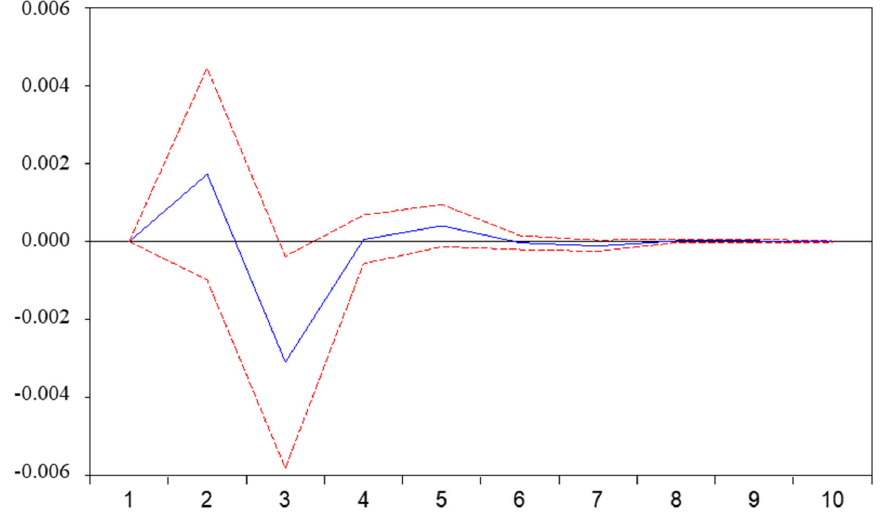
Figure 4. Reaction of carbon futures market to Bitcoin attention. The X ‐ axis refers to the time for response while the Y ‐ axis represents the magnitude of response. The blue line refers to the value while the red line refers to the confidence interval.